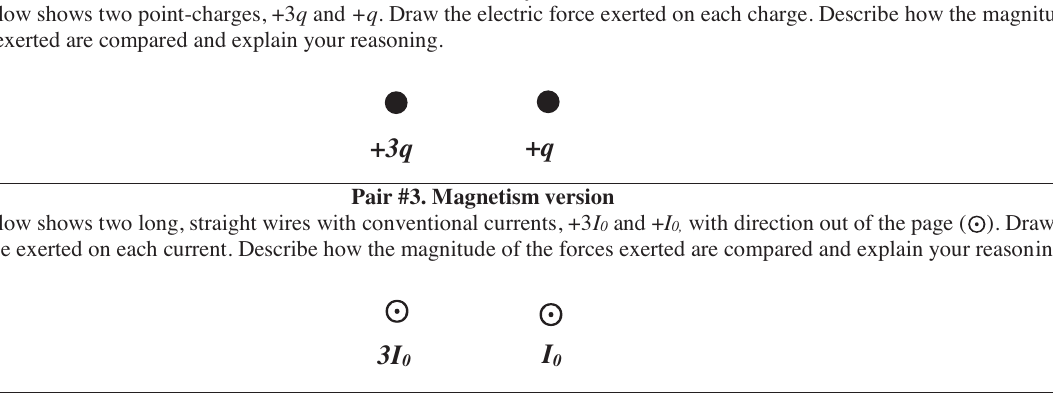
FIG. 5. Pair No. 3 of parallel items. In the electricity version ( E ), the items present two static positive charges with magnitudes þ 3 q and þ q , while the magnetism version ( M ) presents two long cables with conventional electric currents I 0 and 3 I 0 in the same